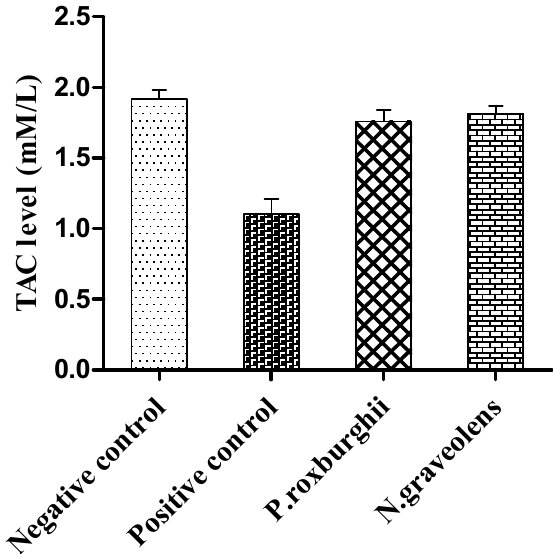
Figure 6. Level of serum total antioxidant capacity in different groups.